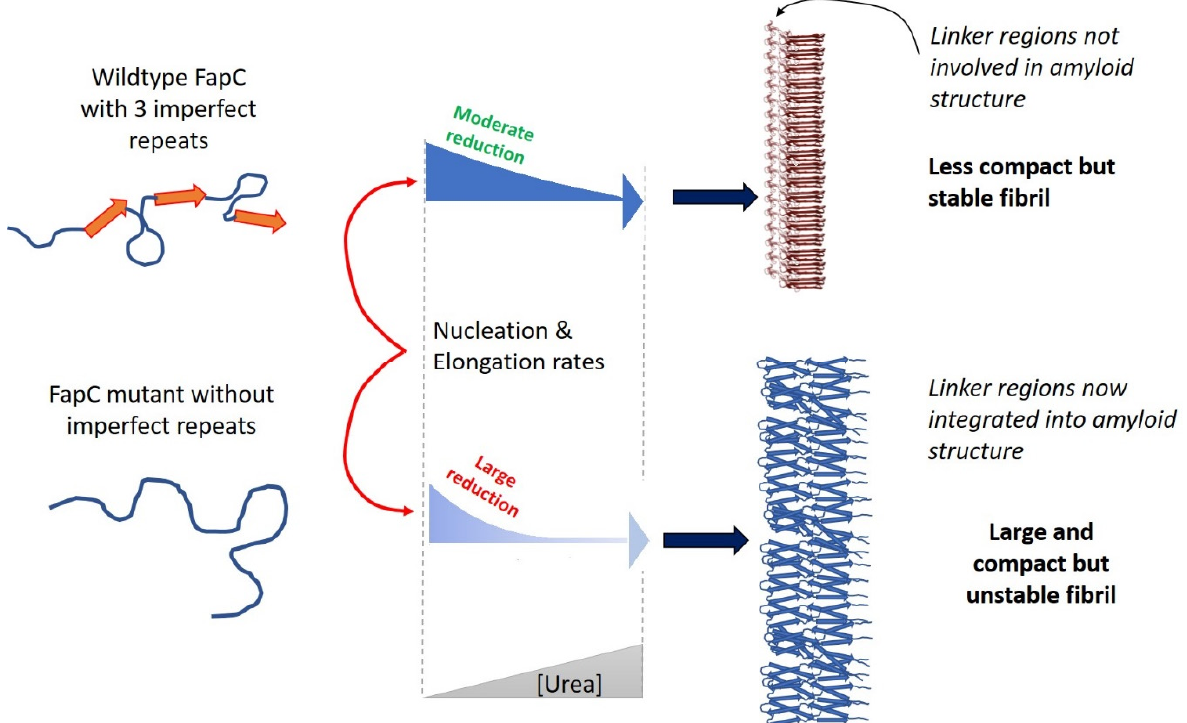
Figure 6. The dependence of FapC fibrillation (nucleation and elongation) on denaturant concentra- tion sheds more light on the folding events accompanying fibrillation. Removal of imperfect repeats leads to a more compact but much less stable fibril, suggesting mobilization of the linker regions to form amyloid. Modified from